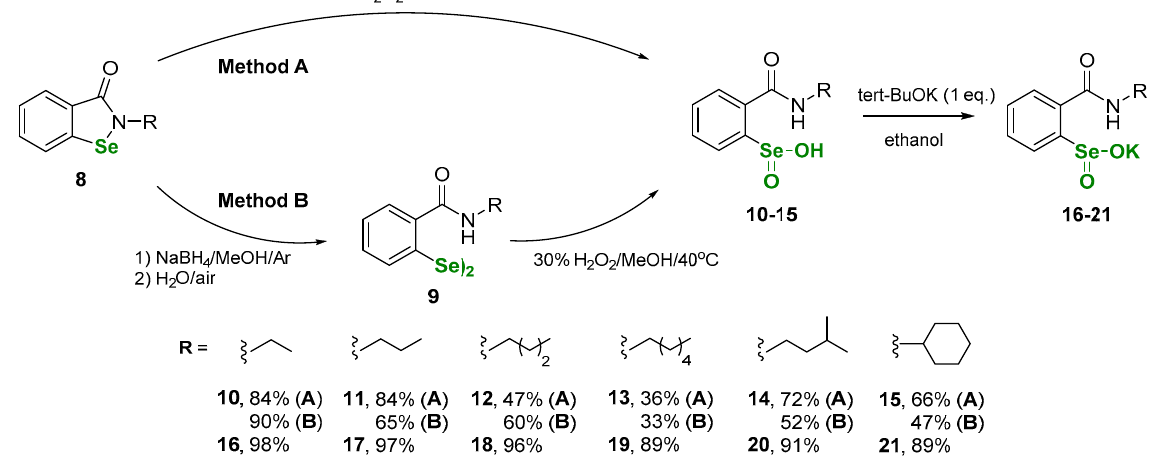
Figure 1. Decomposition of benzeneseleninic acid 15 to the corresponding benzisoselenazolone.